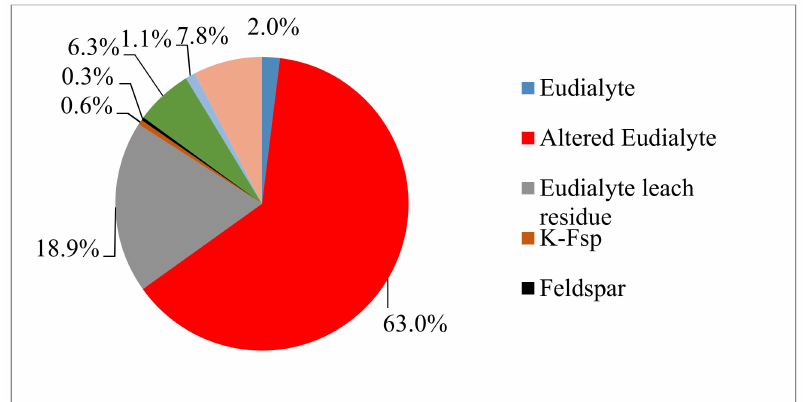
Figure 16. Mineral distribution of a eudialyte leach